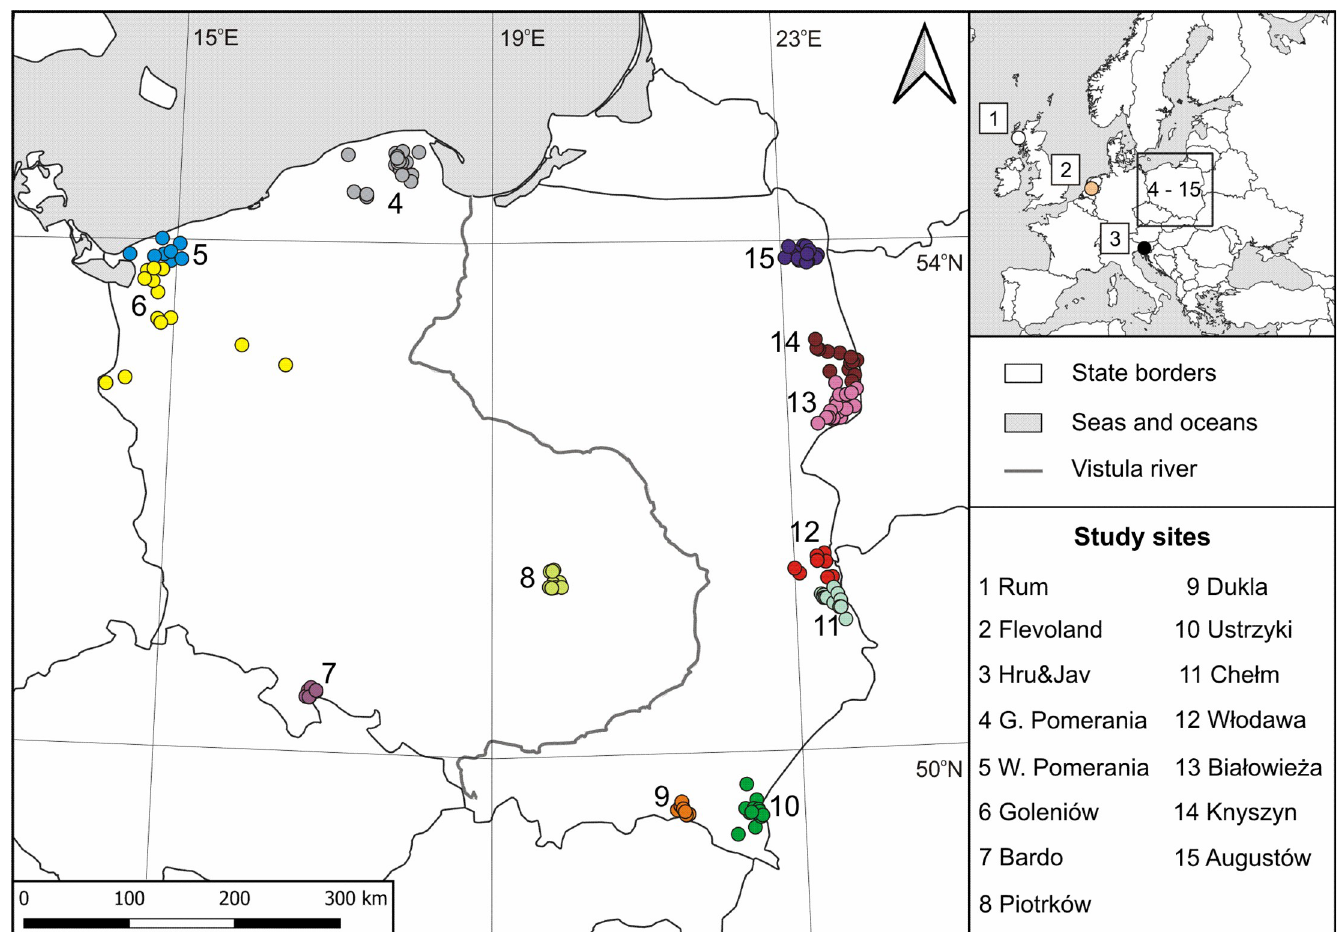
Fig 1. Map of geographical locations of the study sites. The map was created with the ArcGIS 10.3.1 (license no ESU 727916487) software based on a source map from the public Natural Earth website (http://www.naturalearthdata.com/).